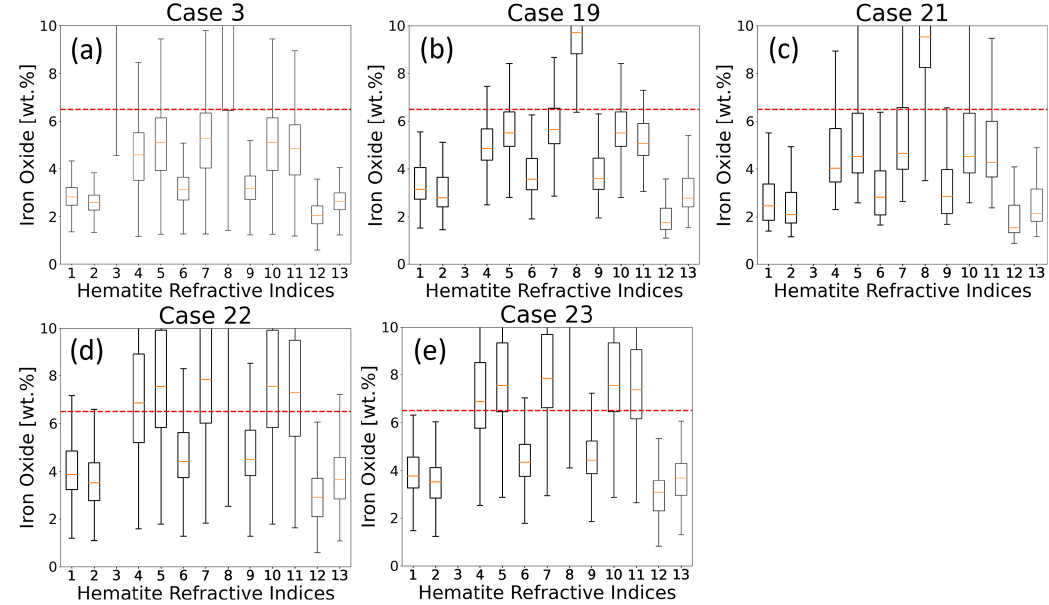
Figure 11. Box-and-whisker plot of iron-oxide content by mass (wt%; y axis) for 13 models of the hematite refractive index ( x axis, numbers 1–13; see Table 1) for the dust cases 3, 19, 21, 22, and 23 presented in Sect. 3.1. The horizontal dashed red line in each panel shows the maximum expected iron-oxide content (6.5wt%) based on in situ